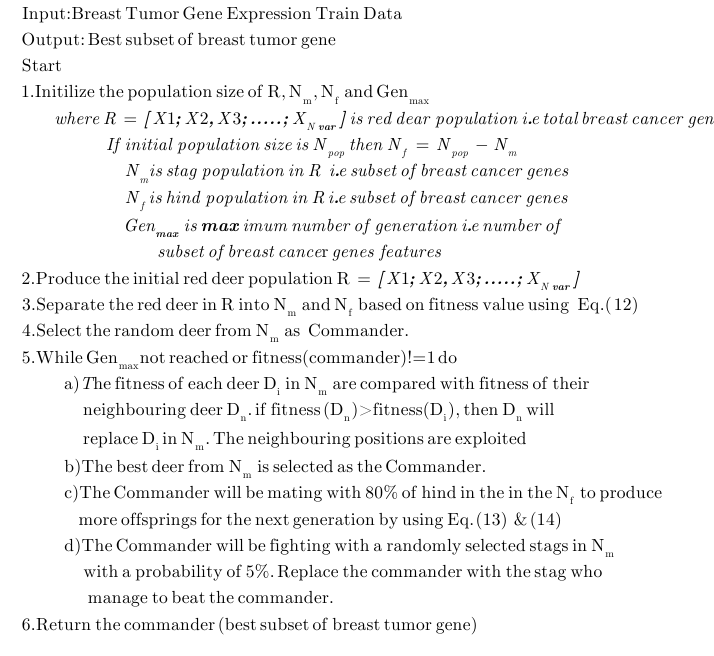
Figure 4. Pseudocode of the Red Deer algorithm.